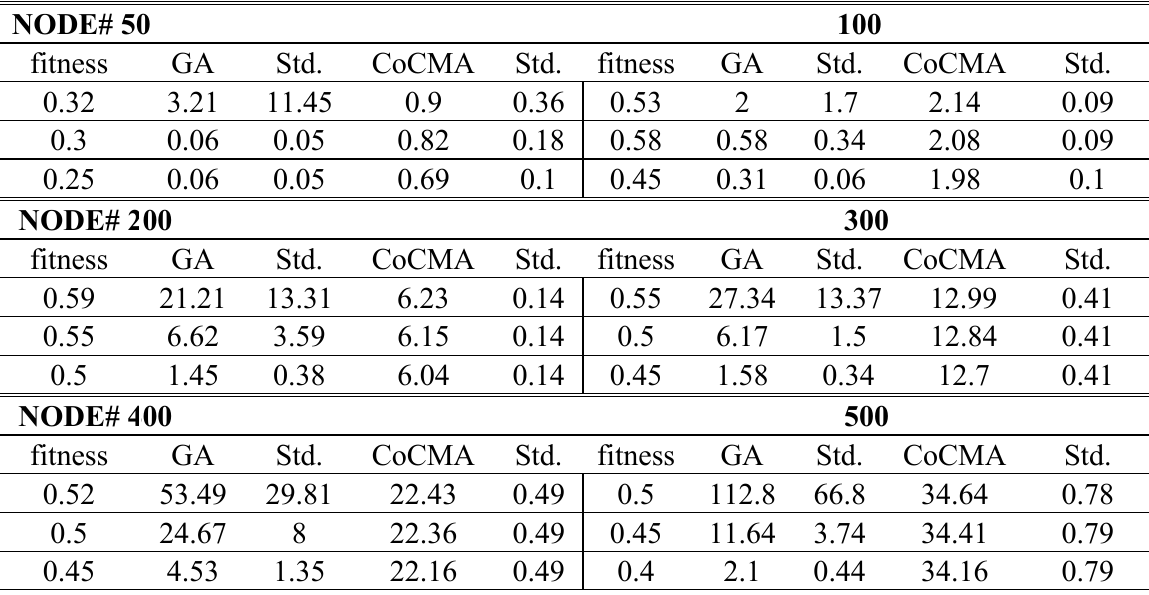
Table 1. Comparison of average computing time (second) for the CoCMA and GA at different fitness values. The number of nodes varies from 50 to 500. There are 64 positions of POIs randomly located in a CWSN with sensing field of 100 m × 100 m. Every case is repeated 30